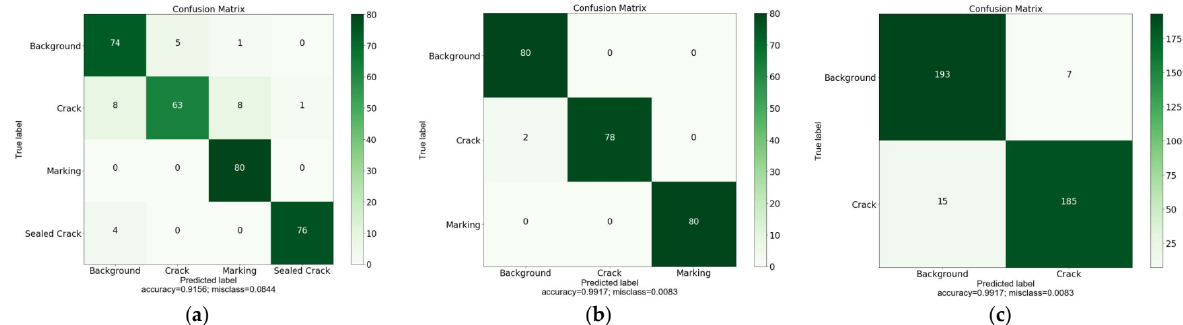
Figure 13. Confusion Matrix of LeViT in different test set: ( a ) JACPs, ( b ) GAPs, and ( c ) Crack500.